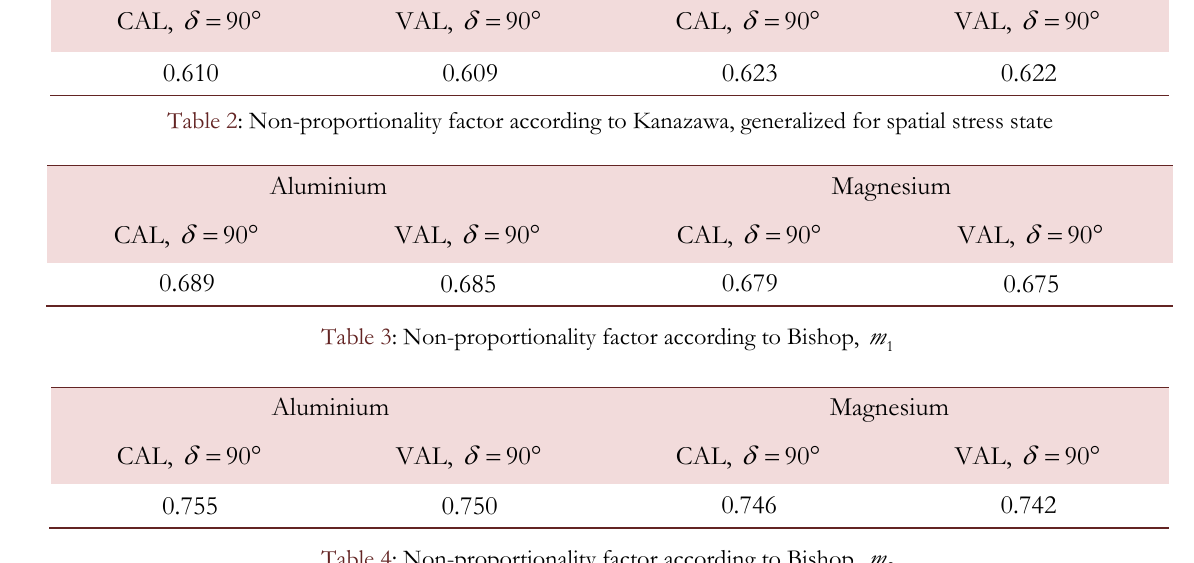
Table 4: Non-proportionality factor according to Bishop,